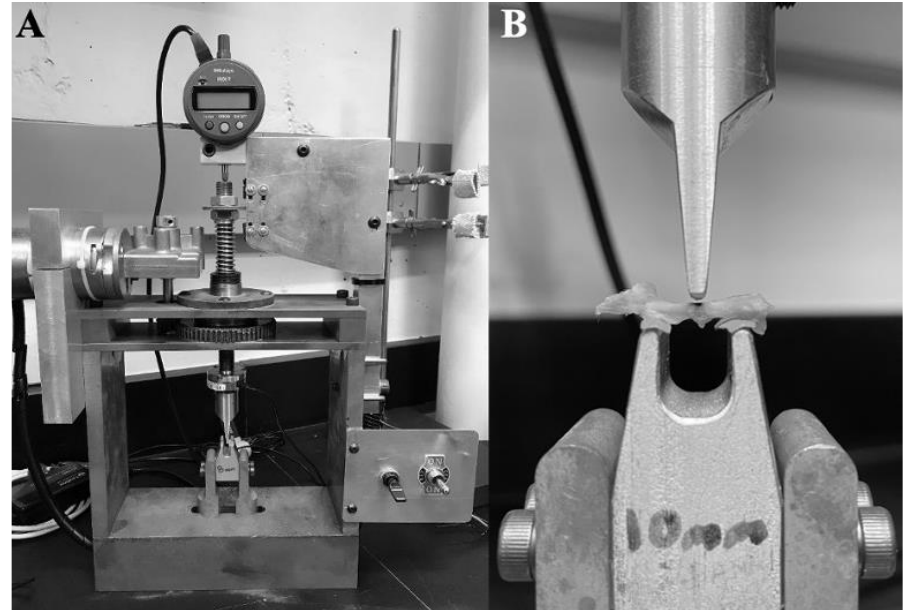
Figure 3. The three-point bender was used in the present study. ( A ) The full machine shown without a bone on the support beams. ( B ) The 10 mm support beams are shown with an example right femur bone, marked at the mid-point (black). bone, marked at the mid-point